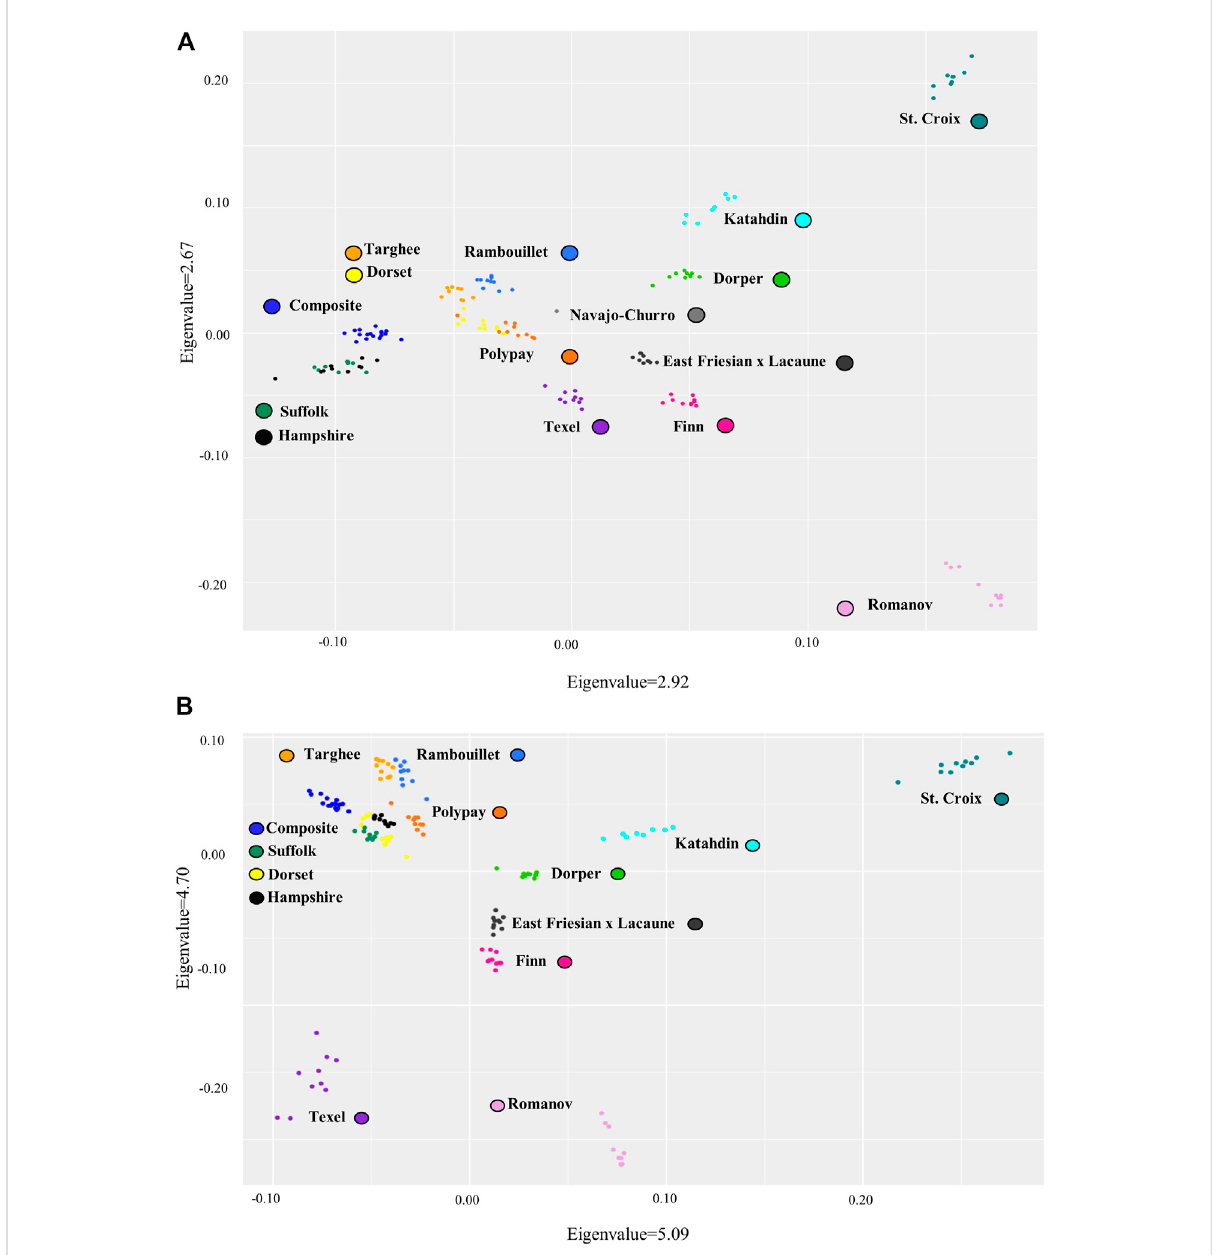
FIGURE 4 Principal component analysis of variant data for the sheep breeds (A) . Bead array variant data and (B) . The consensus WGS variant data from Freebayes. Note: MARC III Composite breed is labeled